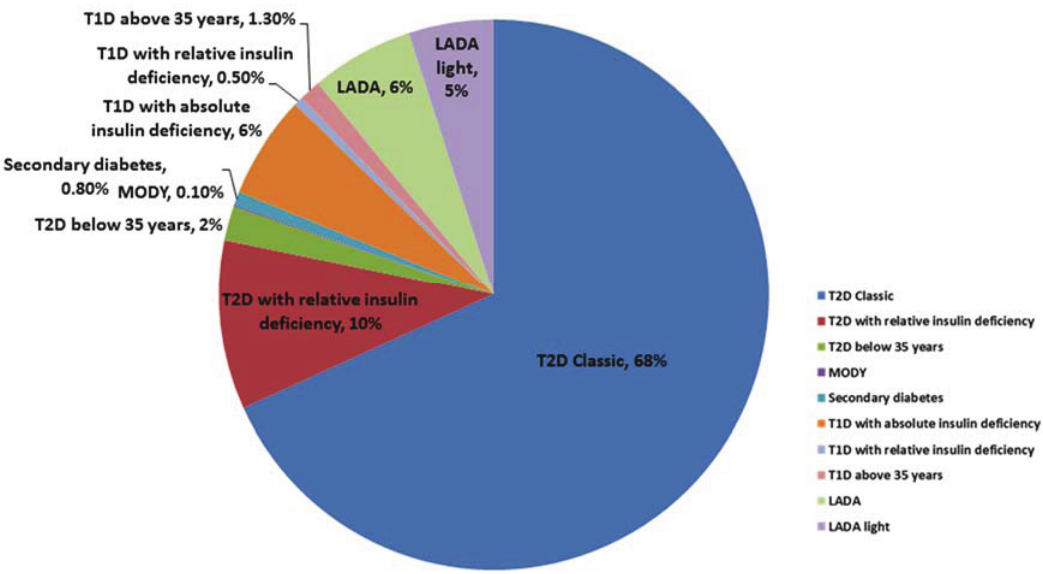
Figure 1. The spectrum of diabetes subgroups. The data is from the ANDIS project (All New Diabetics in Scania) (http://andis.ludc.med.lu.se) in April 2012 which at that